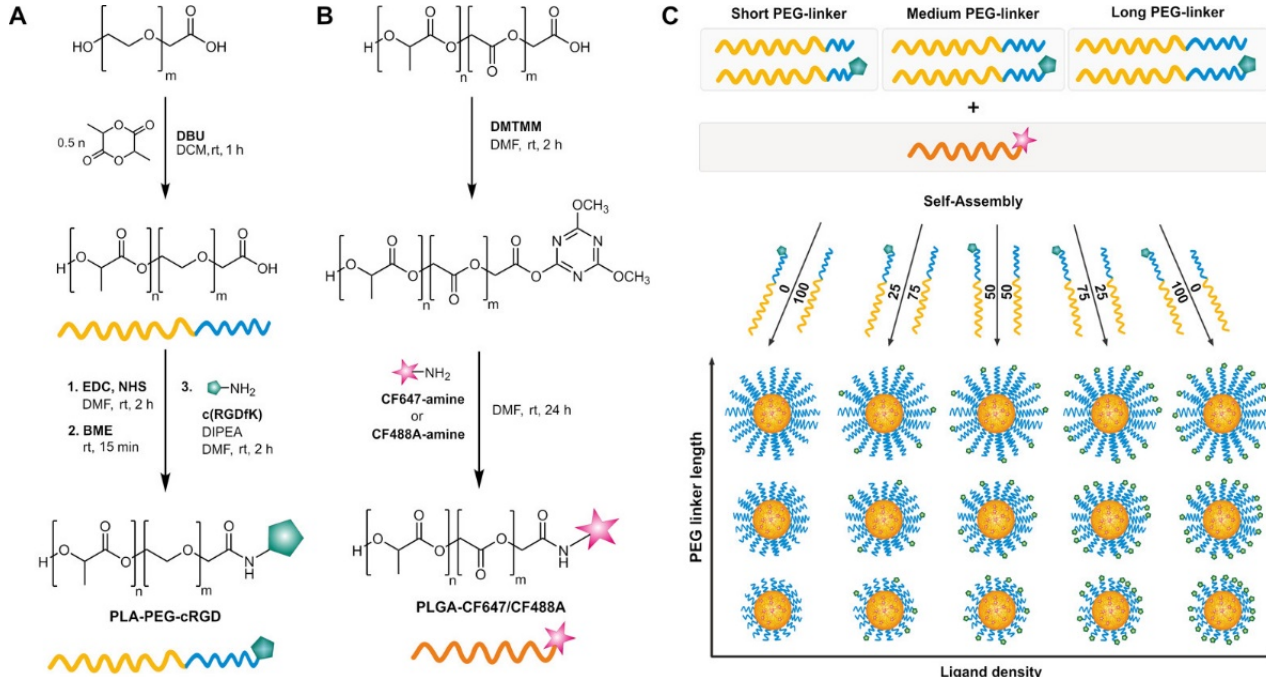
Figure 4. Strategy for the preparation of polymeric NPs with different linker length and ligand density. ( A ) Synthesis of poly(lactic acid)–poly(ethylene glycol) copolymer with carboxyl end (PLA-PEG-COOH) and different lengths of PEG (2, 3.5 and 5 kDa) and conjugation of the targeting moiety (Cyclo(RGDfK)) by EDC/NHS chemistry. ( B ) Fluorescent-labeling with CF™647/CF™488A amine dyes to carboxylic acid-terminated PLGA using 4-(4,6-dimethoxy-1,3,5-triazin-2-yl)-4-methylmorpholinium chloride (DMTMM). ( C ) Preparation of polymeric NPs with different PEG linker lengths and ligand densities. EDC: N-(3-dimethylaminopropyl)-N ′ -ethylcarbodiimide, NHS: N-hydroxysuccinimide, DBU: 1,8-Diazabicy- clo[5.4.0]undec-7-ene, BME: beta-mercaptoethanol, DCM: dichloromethane, DMF: dimethylformamide, DIPEA: N,N- diisopropylethylamine. Adapted with permission from Reference [63], American Chemical Society, 2019.